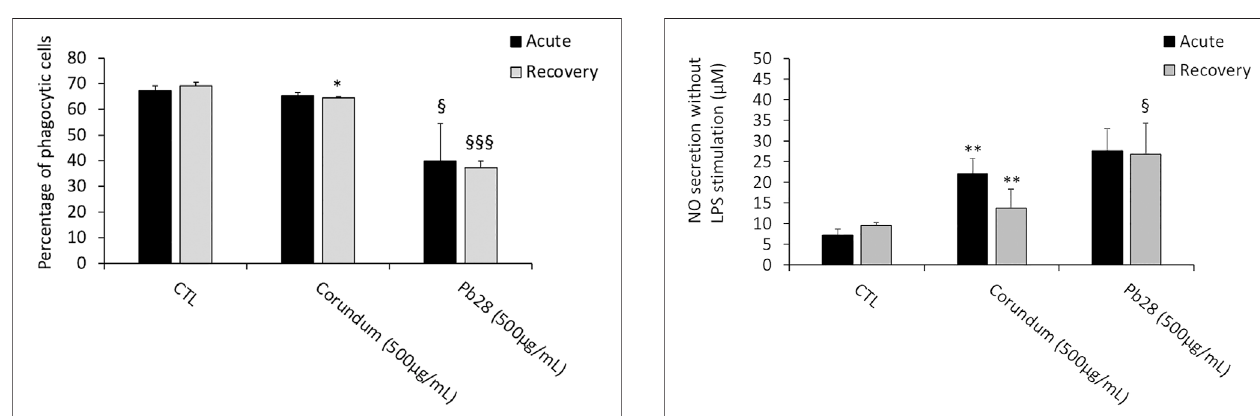
FIGURE7| Phagocyticcapacity.Blackbars;acuteexposure(lastdayof culture (cid:1) 24 h). Grey bars; recovery exposure ( fi rst day of culture (cid:1) 24 h) and 9 days recovery post exposure. Percentage of cells able to phagocyte fl uorescentY/Glabeledlatexbeads.DataarerepresentedasMean+SD. Signi fi cance symbols: *, signi fi cant change compared to negative control only (cells without treatment). §, signi fi cant change compared to negative control and corundumcontrol(same concentration).Numberofsymbols:1: p < 0.05, 2: p < 0.01, 3: p < 0.001 (Student t test, N (cid:1) 3).